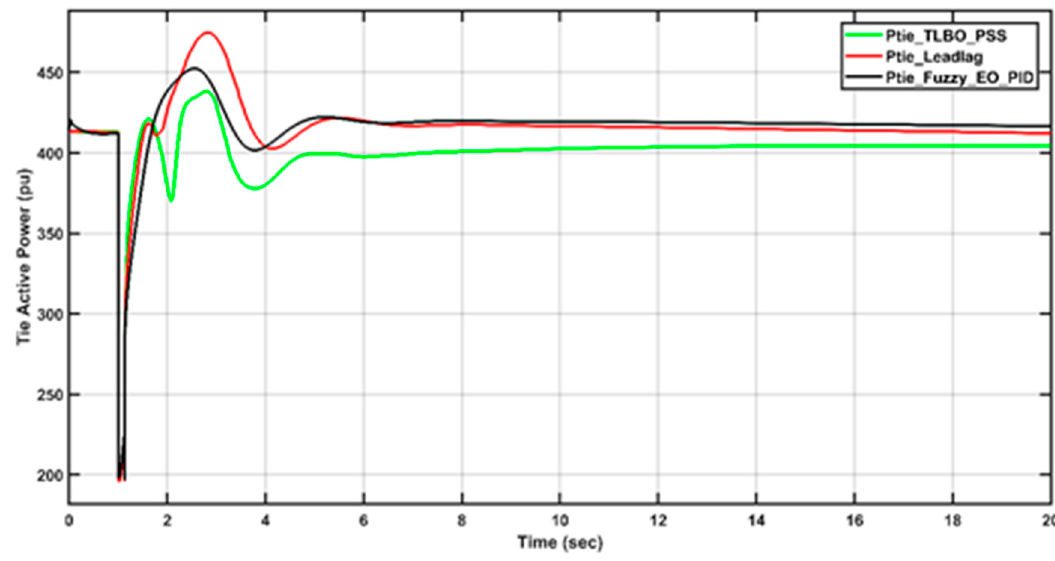
Figure 16. Focusing part 2 on the dynamic reference case.